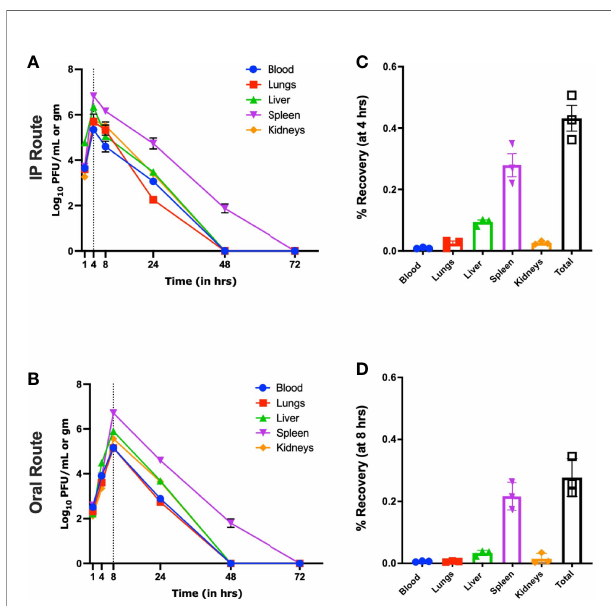
FIGURE 2 | Pharmacokinetics of øKp_Pokalde_002 in vivo via IP and oral route in the absence of host bacteria Kp56. The phage concentration in log 10 PFU/ml in blood, lungs, liver, spleen, and kidney after 1, 4, 8, 24, 48, and 72 h of phage administration via IP (A) and oral (C) route (200 µl of ~1 x 10 8 PFU/ml). The result represents the mean from three independent experiments. Biodistribution of øKp_Pokalde_002 via IP (B) and oral (D) route at 4 h and 8 h, respectively. The dotted vertical line indicates T max . Percentage recovery was calculated by dividing phage titer at the respective time-point by the administered dose (n = 3 mouse per time